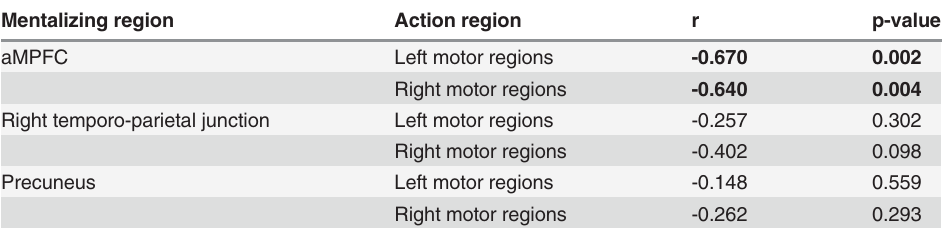
Table 2. Correlations between mentalizing and action regions. Mentalizing region Action region r p-value aMPFC Left motor regions -0.670 0.002 Right motor regions -0.640 0.004 Right temporo-parietal junction Left motor regions -0.257 0.302 Right motor regions -0.402 0.098 Precuneus Left motor regions -0.148 0.559 Right motor regions -0.262 0.293 Correlations between Mentalizing regressor activity in mentalizing regions and Action regressor activity